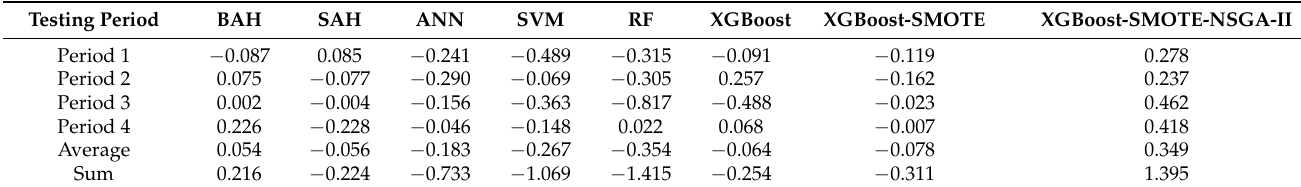
Table 6. Accumulated return results for rebar futures simulation